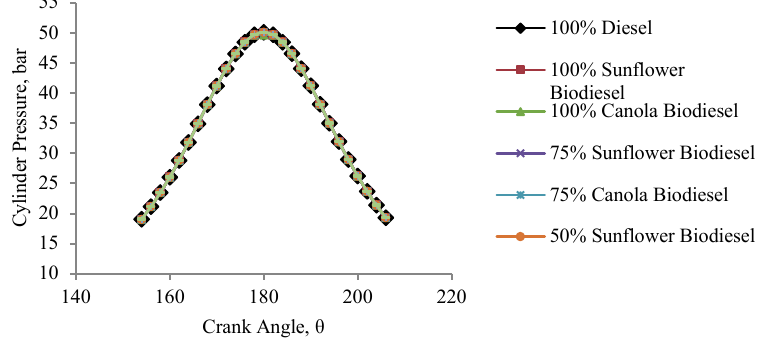
Fig. 5. Cylinder pressure at 1500 rpm against crank angle.